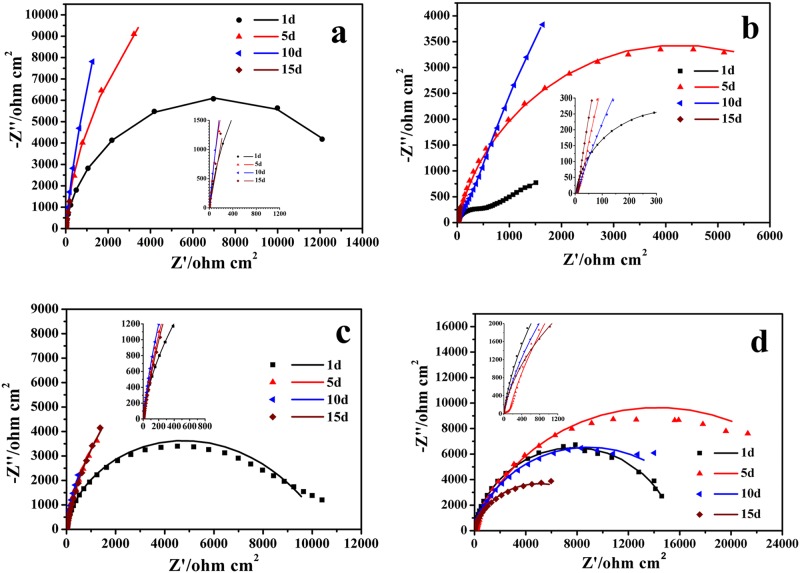
EIS for EQ70 in SRB media as function of the time after polarization at different potentials.a) OCP; b) -0.85 VSCE; c) -0.95 VSCE; and d) -1.05 VSCE.